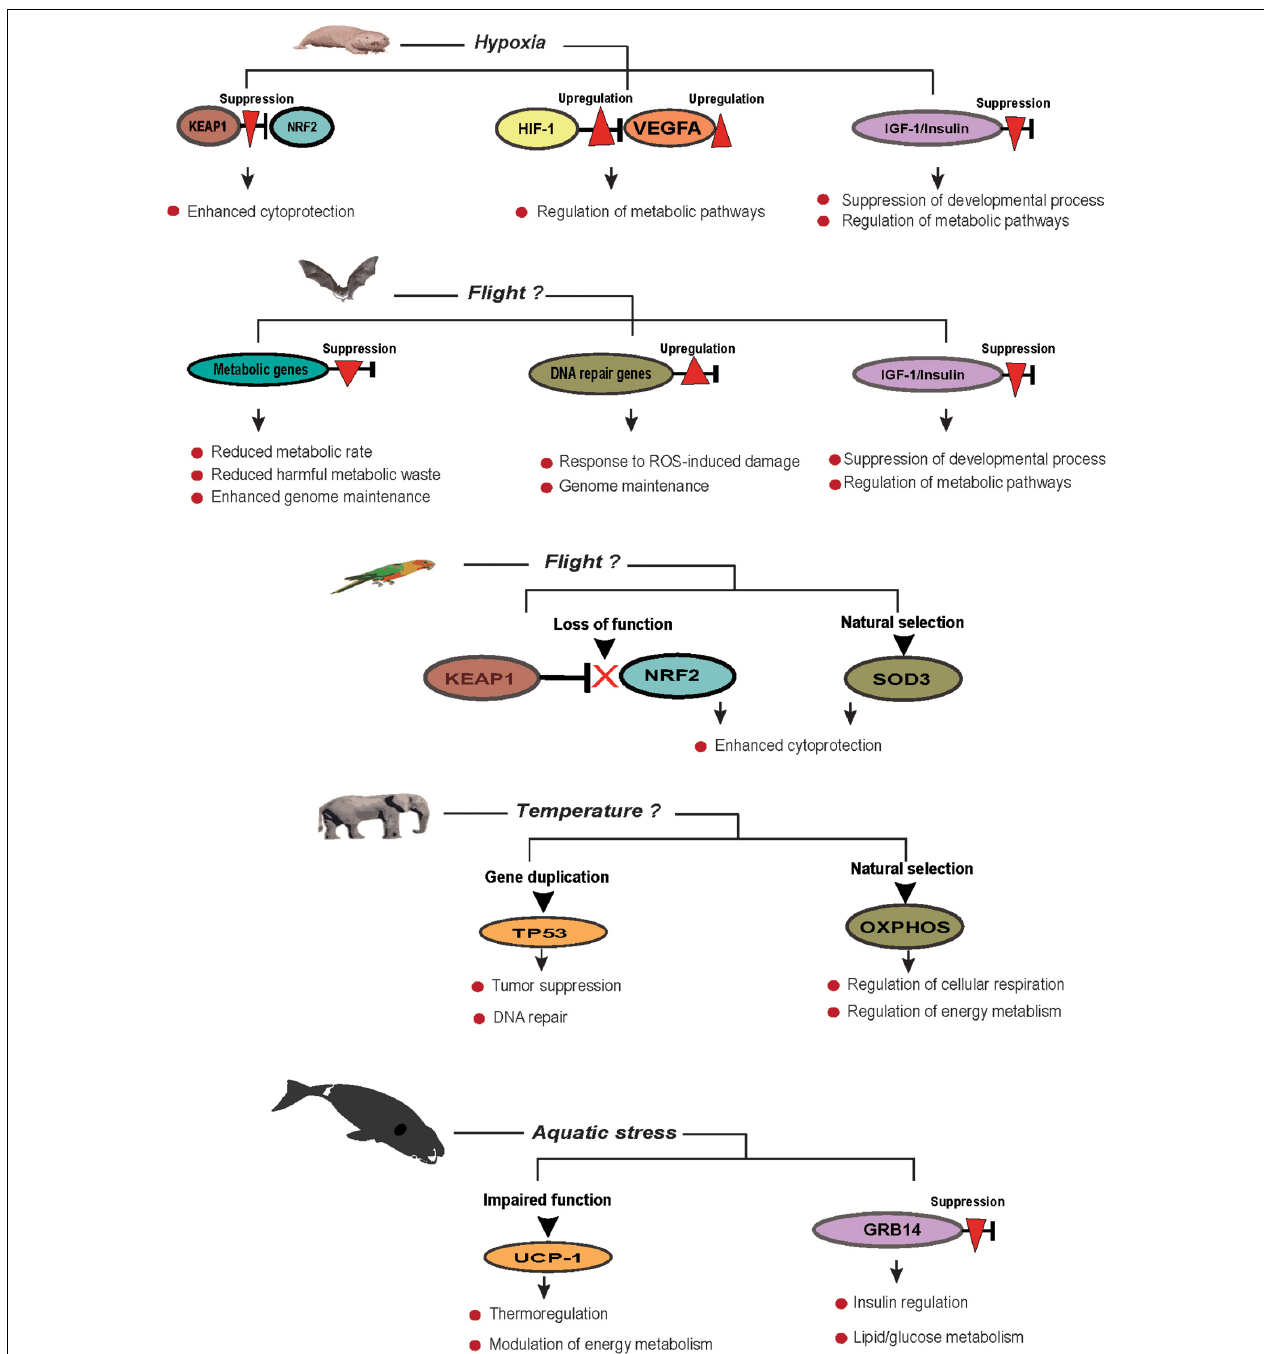
FIGURE 1 | Environmental and morphological contributions to an extended